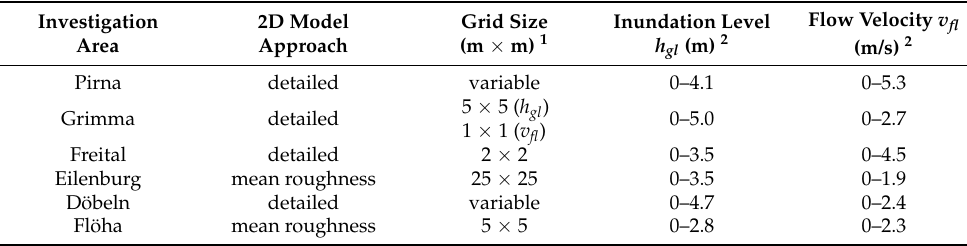
Table 2. Overview of the 2002 flood scenarios (for interim state cf.